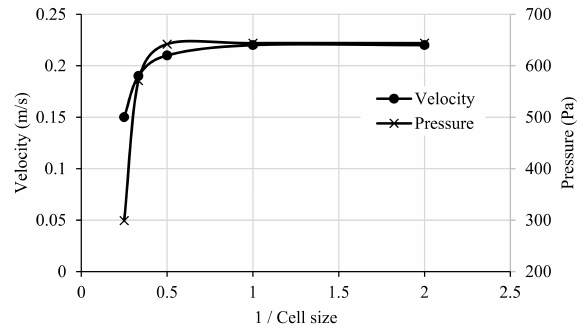
Figure 5. The mesh convergence study results.